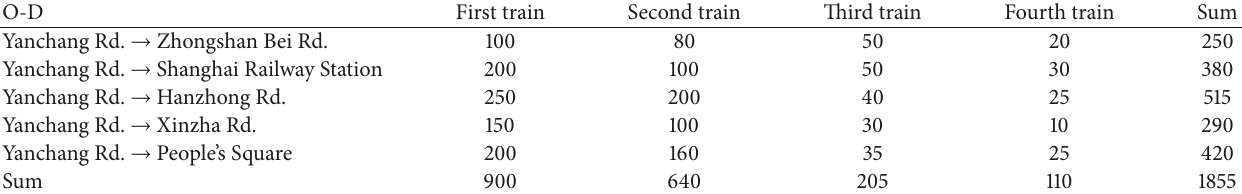
Table 1: Distribution of passengers boarding on different trains during 8:00 AM ∼ 9:00 AM at Yanchang Rd. O-D First train Second train Third train